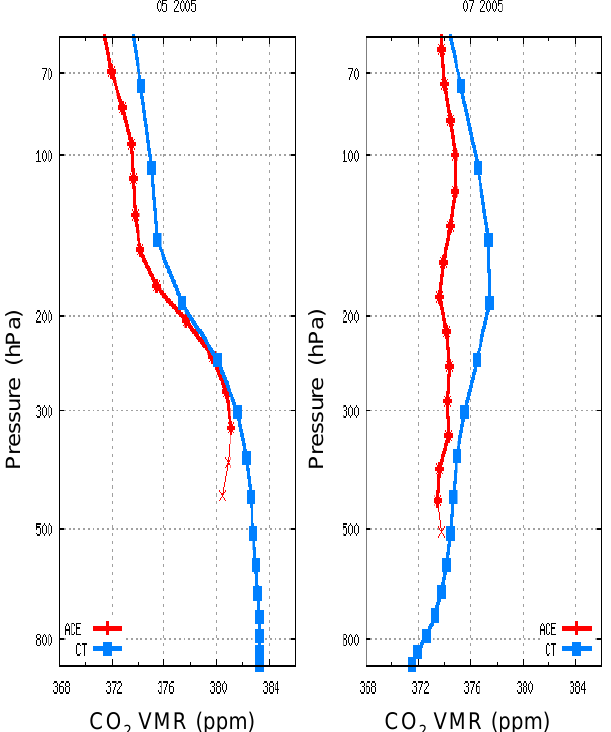
Fig. 7. CO 2 concentration (x-axis inppm) evolution with pres- sure (y-axis in hPa) for May (left) and July (right) for 2005 for the 50 ◦ N–60 ◦ N latitude band. ACE-retrieved profile is in red and CT profile is in blue. The thin red line indicates that less than 10 occul- tations were available. ACE CO 2 standard deviation at each altitude (not shown in the picture) fluctuates around 3ppm ( ±